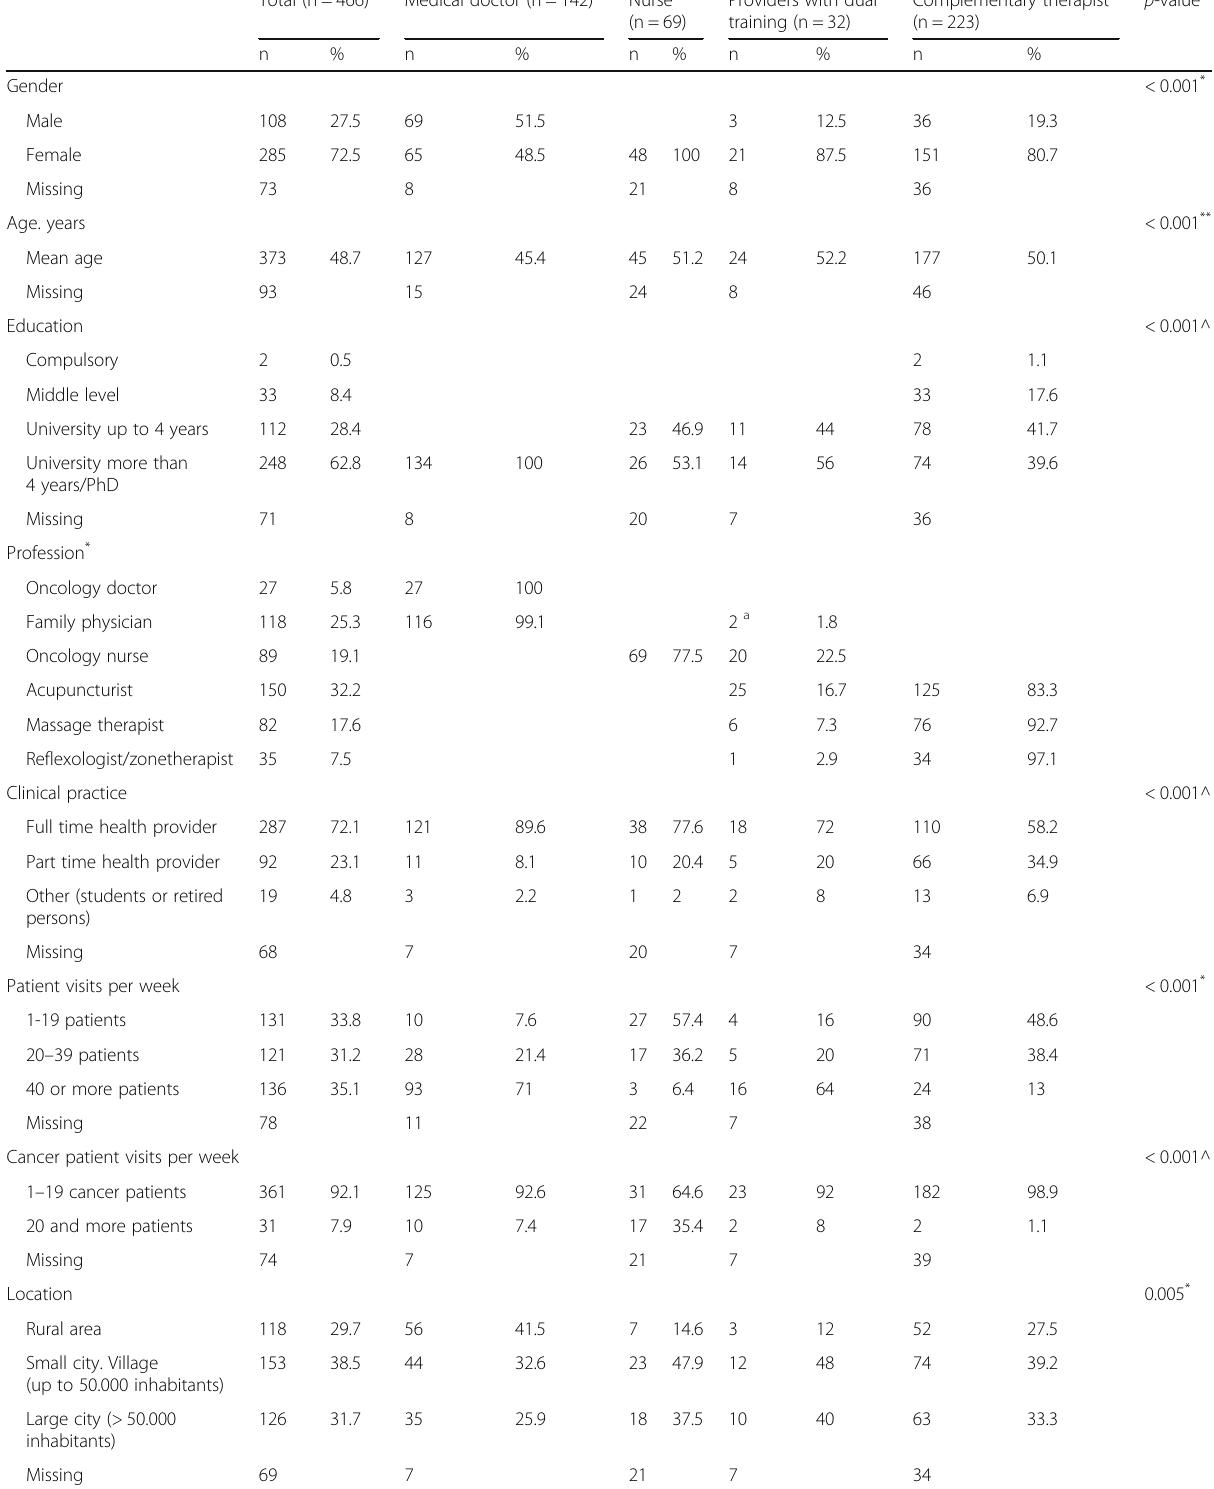
Table 2 Characteristics of the participants (n = 466)